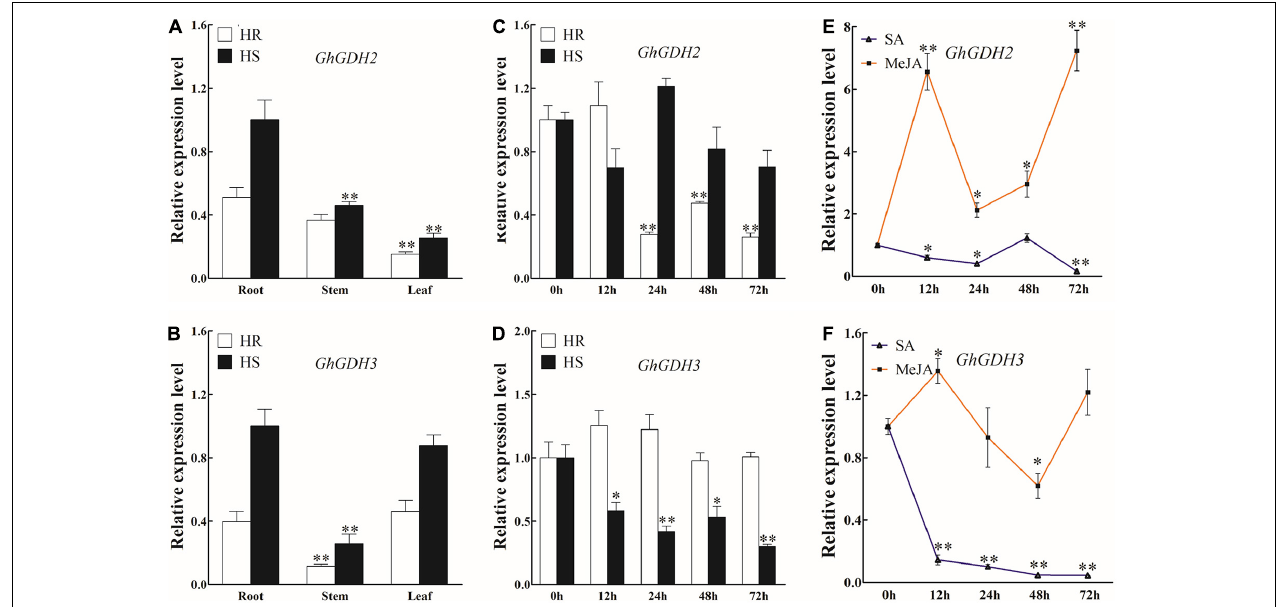
FIGURE 6 | Expression profiles of GhGDH2 in different cotton tissues and under Verticillium dahliae , salicylic acid (SA), or methyl jasmonate (MeJA) treatment. (A,B) Expression profiling of (A) GhGDH2 and (B) GhGDH3 in roots, stems, and leaves in Shidalukang 1 (HR) and Junmian 1 (HS). Root, stem, and leaf samples from two-leaf stage cotton seedlings were collected. (C,D) Expression patterns of (C) GhGDH2 and (D) GhGDH3 in the roots of HS and HR at 0, 12, 24, 48, and 72 h post-inoculation (hpi). (E,F) Expression changes of (E) GhGDH2 and (F) GhGDH3 in the roots of HR after treatment with SA or MeJA. Samples collected at 0, 12, 24, 48, and 72 hpi after SA or MeJA treatment were used in reverse transcription quantitative PCR. GhUBQ7 was used as the control. Values represent mean ± SE of three independent biological replications (five individual plants per replicate). ∗ and ∗∗ represent significant differences from 0 hpi at P < 0.05 and P < 0.01, respectively, based on Student’s t